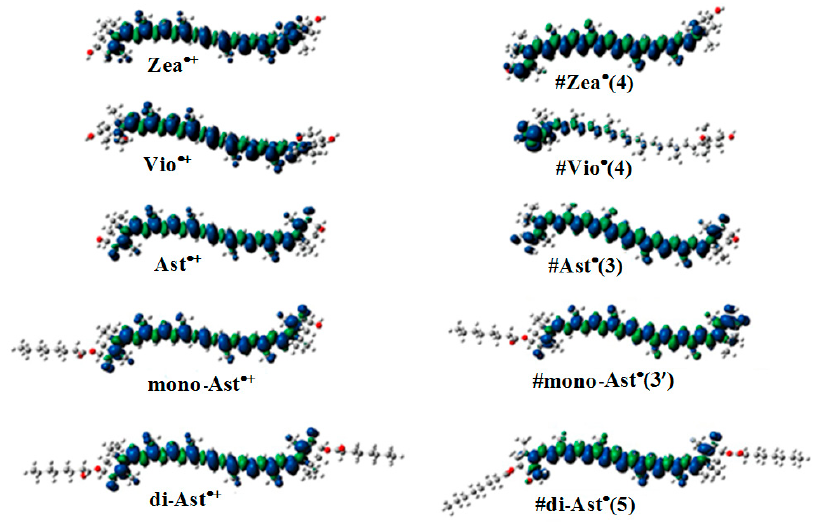
Figure 5. Unpaired spin density distribution for radical cations (left) and the corresponding most favorable (lowest energy) proton loss neutral radicals (right) for selected carotenoids.